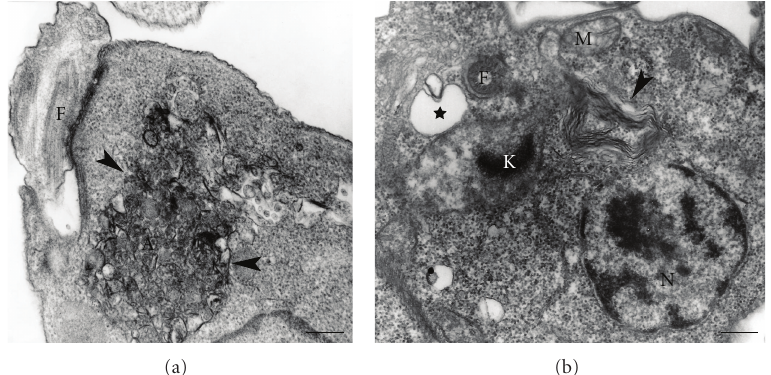
Figure 8: Promastigotes treated with quinuclidine and azasterol, respectively, showing the presence of structures related with autophagy such as a large vacuole containing many membrane profiles ((a), arrowheads ), and a myelin-like figures involving part of the cytosol ((b), arrowhead ). Star indicates the presence of a possible contractile vacuole near the flagellar pocket. A, autophagosome; F, flagellum; K, kinetoplast; M, mitochondrion; N, nucleus. (a) This image is reproduced with permission from [66] Elsevier. Bars, 0 . 25 μ m.